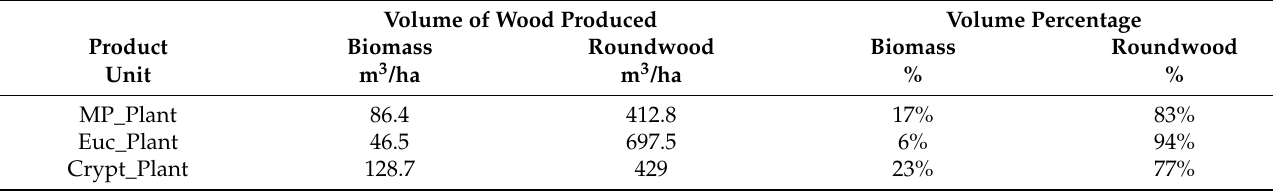
Table 6. Calculation of percentages of volume allocation.